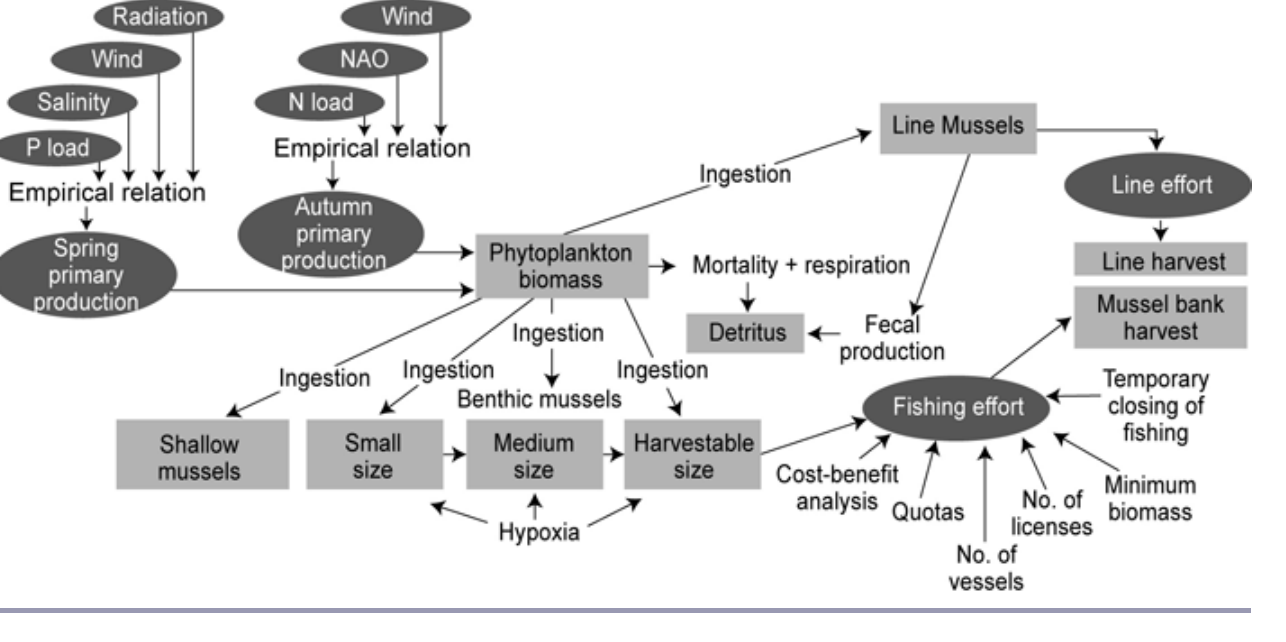
Fig. 2 . Conceptual diagram of the bioeconomic model. Gray boxes represent state variables; circles and arrows represent